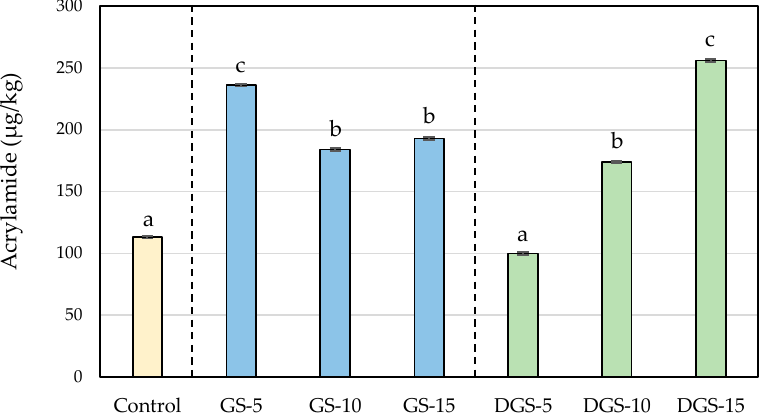
Figure 2. Acrylamide (µg/kg) concentrations in wheat-based biscuits (control) with added ground chia seeds (GS) and defatted ground chia seeds (DGS) at 5, 10 and 15%. Values are mean ± standard deviation. Different letters mean significant differences ( p < 0.05).